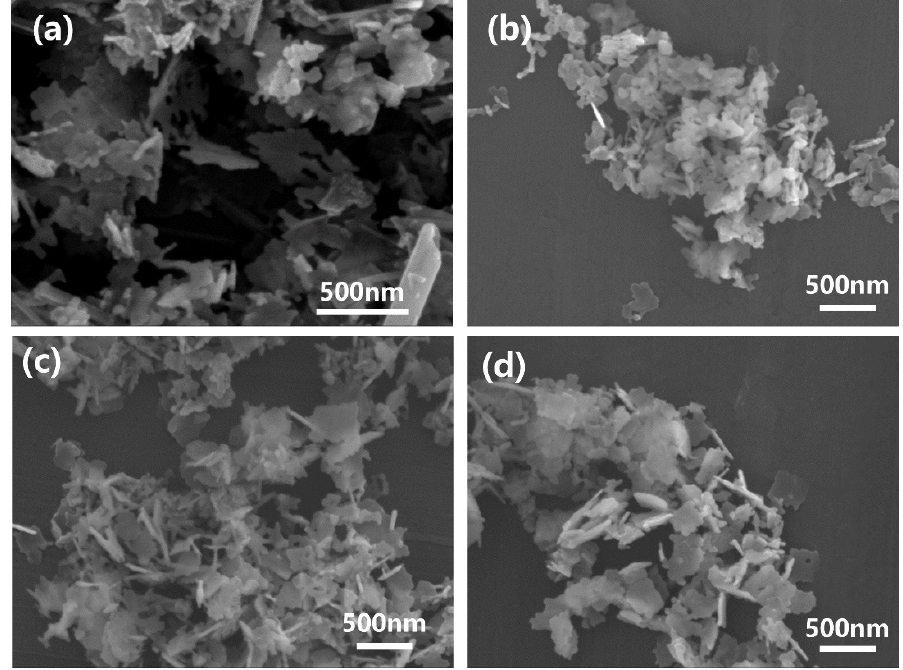
Figure 4. SEM images of MgO-Y 2 O 3 nanopowders, with different seed contents of ( a ) 0%, ( b ) 1%, ( c ) 5% and ( d ) 10%, synthesized at a hydrothermal heat treatment temperature of 230 ◦